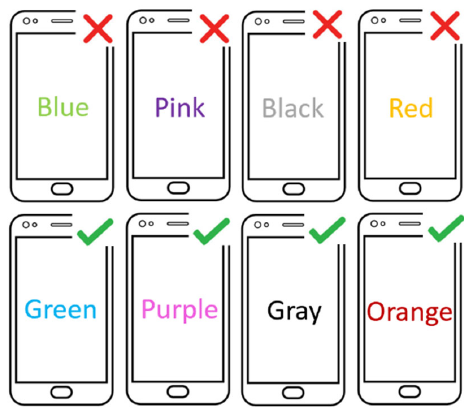
Figure 2. Example of correct and wrong cases.